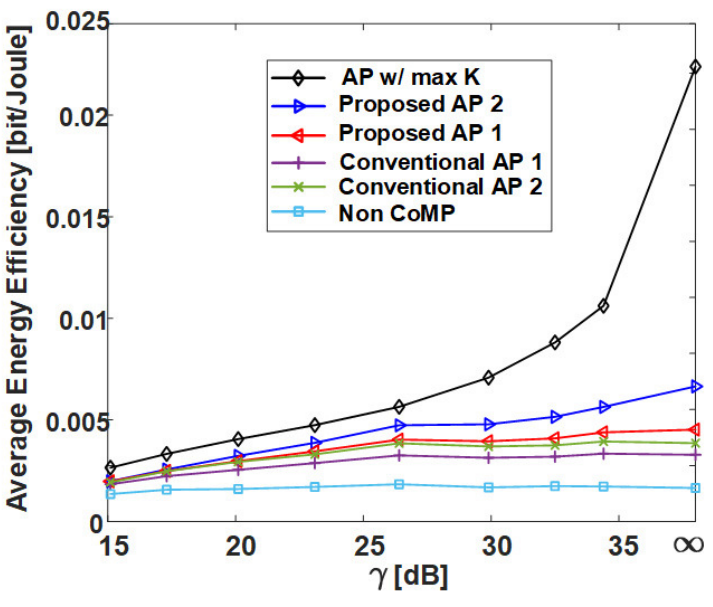
Figure 15. Average energy efficiency of various clustering schemes with respect to γ in uniform